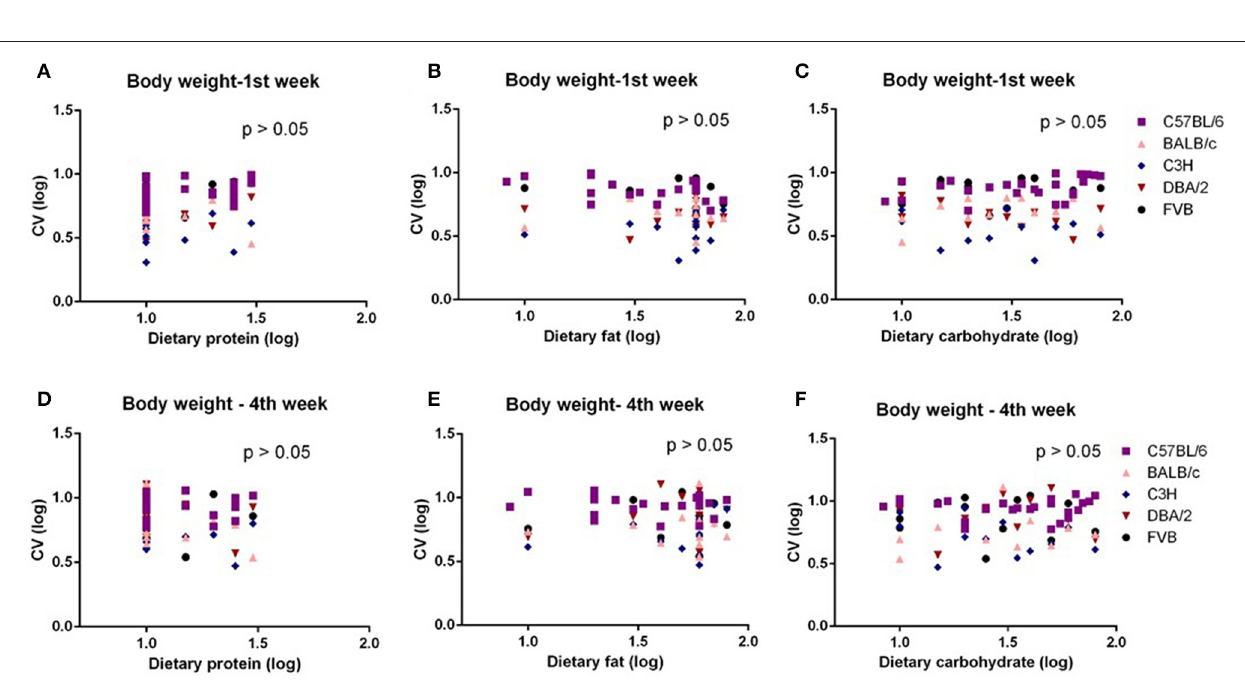
FIGURE 4 | The diagram showing the relationship between dietary macronutrient content and coefficient of variation (CV) of body weight of the 1st week and 4th week after exposure to different diets. The correlations between logged dietary fat, protein, and carbohydrate contents and (A–C) logged CV of body weight of the 1st week and (D–F) 4th week at different diet treatment periods, respectively ( n = 7–21).